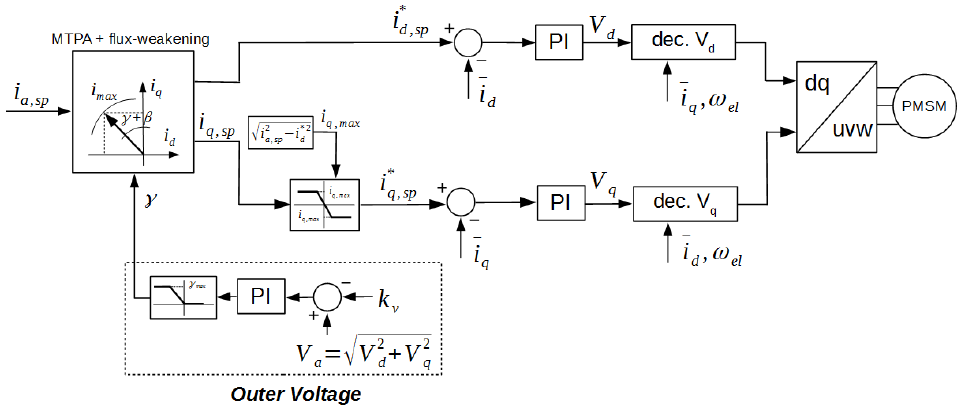
Figure 5. Traditional FW control scheme proposed in [17] based on outer